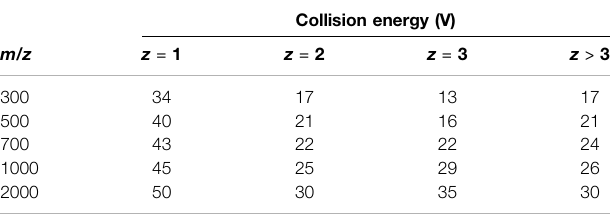
TABLE 1 | MS/MS collision energy settings for different mass-to-charge ratios ( m/z ) and charge states ( z